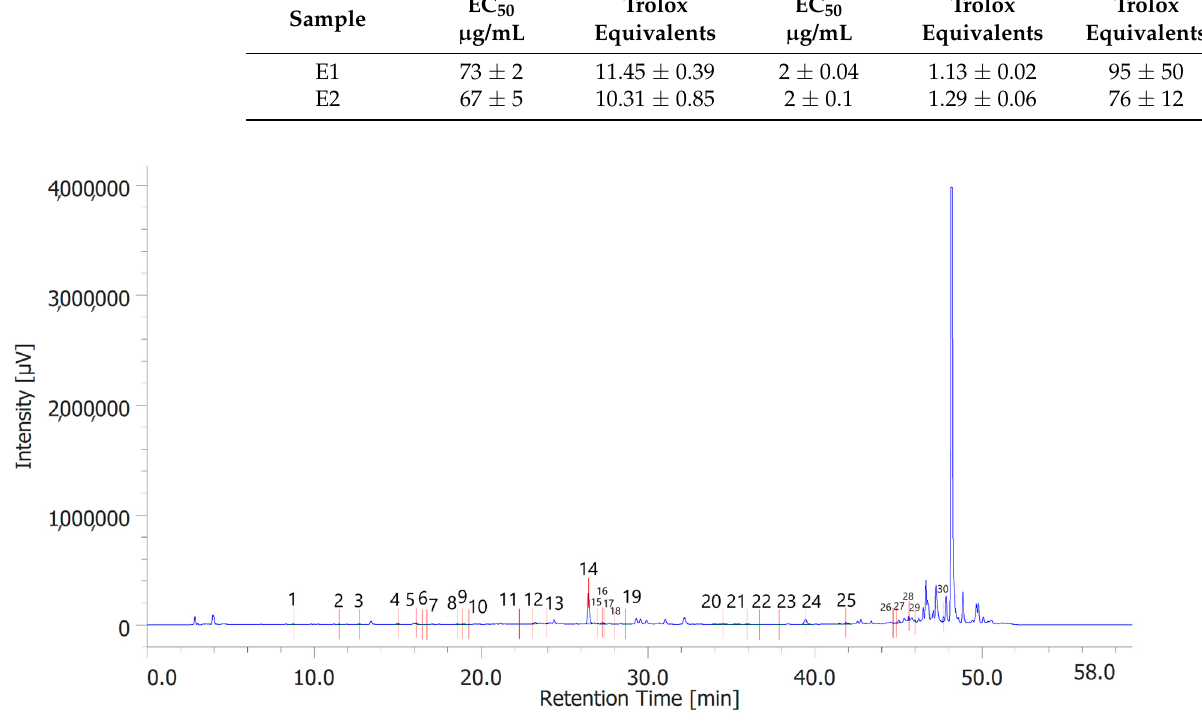
Figure 1. Phenolic compounds identified in the hydroalcoholic extract of hemp inflorescences. Among the compounds quantitavely determined, benzoic acid (peak #14) was the prominent.